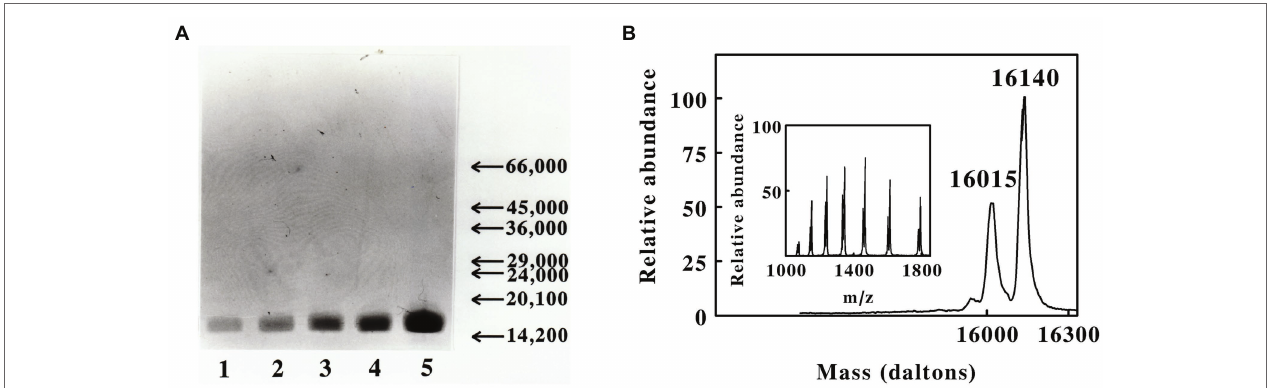
FIGURE 2 | Masses of the polypeptides present in the preparation of cytochrome 579 purified from cell-free extracts of L. ferriphilum . (A) Sodium dodecyl sulfate- polyacrylamide gel electrophoresis of the purified cytochrome under denaturing and reducing conditions. Protein bands were visualized by staining with Coomassie Blue. Lanes 1 through 5 represent 0.85, 1.7, 3.3, 7.5, and 15 μ g of purified protein, respectively. The arrows and numbers on the ordinate represent the migration positions and masses, respectively, of stained bands associated with protein molecular mass standards (primary data not shown). The mass standards from high to low were bovine serum albumin, ovalbumin, yeast alcohol dehydrogenase, carbonic anhydrase, bovine chymotrypsin, soybean trypsin inhibitor, and bovine α - lacalbumin. (B) Deconvoluted positive-ion electrospray mass spectrum of purified cytochrome 579, showing the masses of the neutral polypeptides. Inset , primary data of the electrospray mass spectrum of the purified protein, showing the ions formed by multiple attachment of protons to the